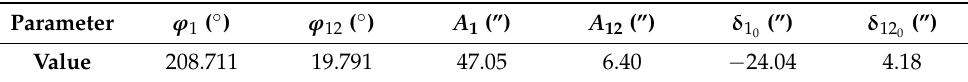
Table 6. The parameter values in the angle measurement error compensation function of reading head